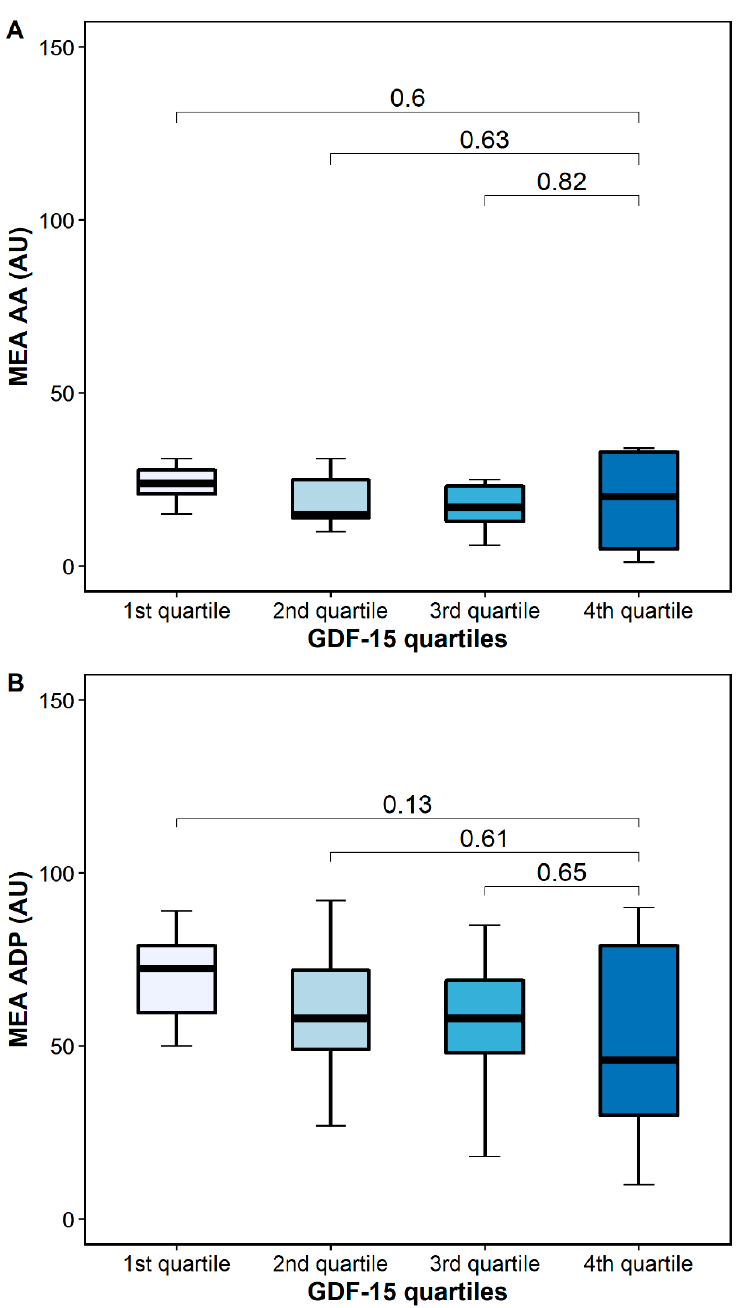
Figure 6. Platelet aggregation by multiple electrode aggregometry (MEA) according to GDF-15 quartiles. ( A ) Arachidonic acid-inducible platelet aggregation by multiple electrode aggregometry. ( B ) Adenosine diphosphate (ADP)-inducible platelet aggregation by multiple electrode aggregometry. The boundaries of the box show the lower and upper quartiles of data, and the line inside the box represents the median. Whiskers were drawn from the edge of the box to the highest and lowest values that are outside the box but within 1.5 times the box length.